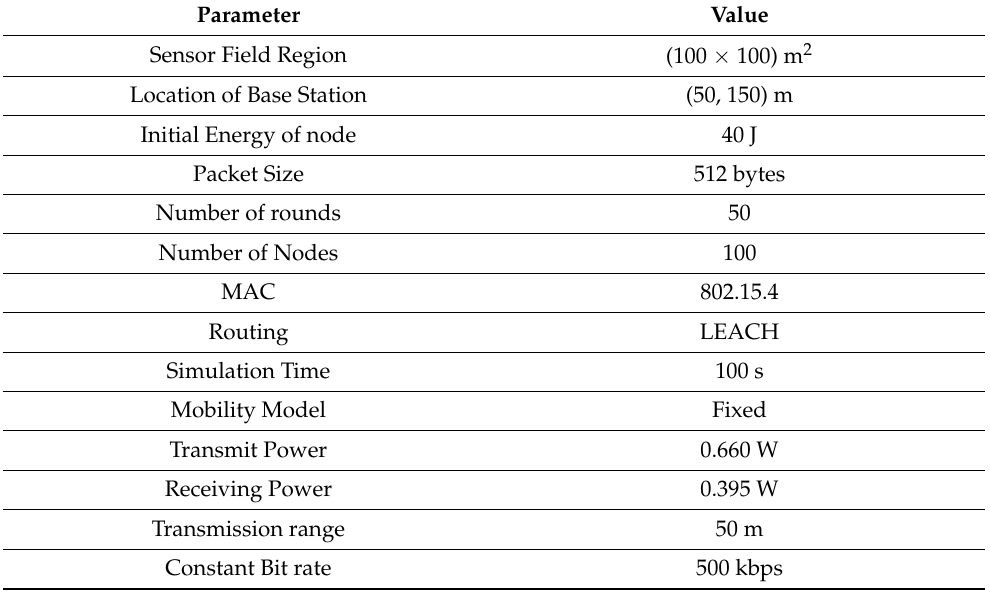
Table 1. Simulation